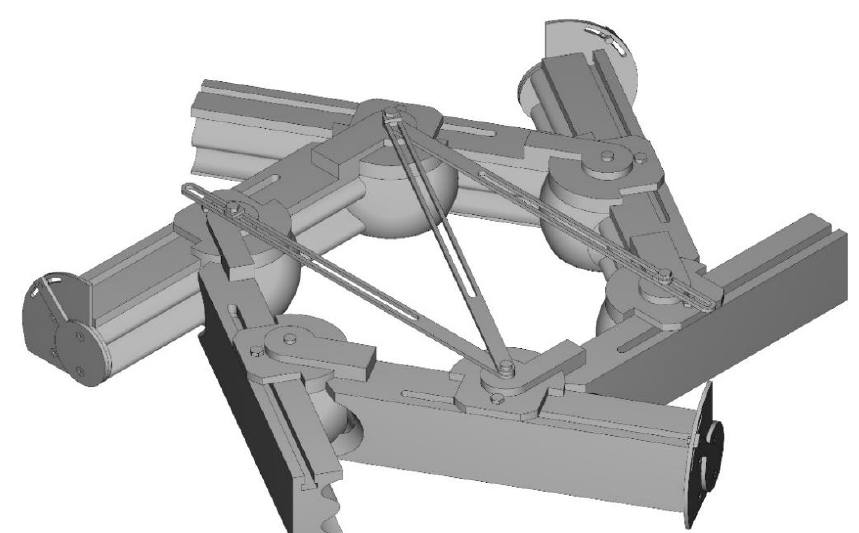
Fig. 3 The adjustable mould in hexagonal